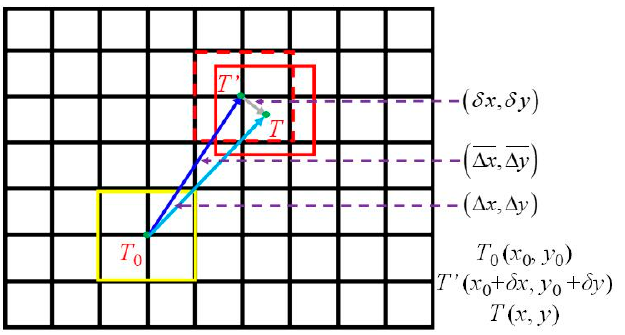
Figure 3. Sketches of motion estimation using spatio-temporal context (STC) tracking and Taylor approximation.